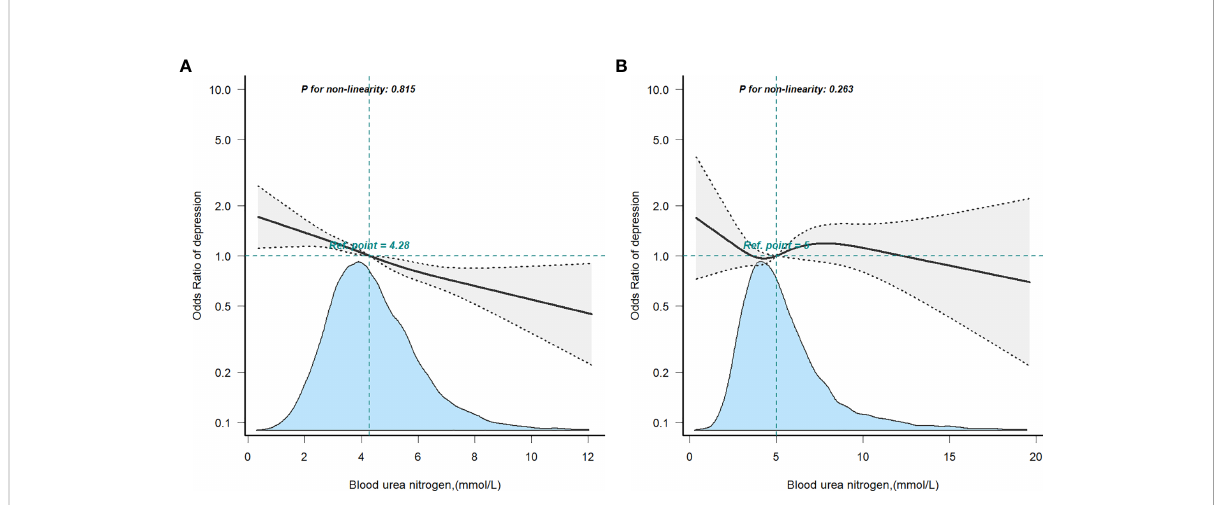
FIGURE 3 Restricted cubic spline model of the odds ratios of blood urea nitrogen with depression in non-T2D (A) or T2D (B) . Adjusted for age, gender, race, BMI, educational level, smoking status, alcohol consumption, laboratory Results, physical activity and hypertension.